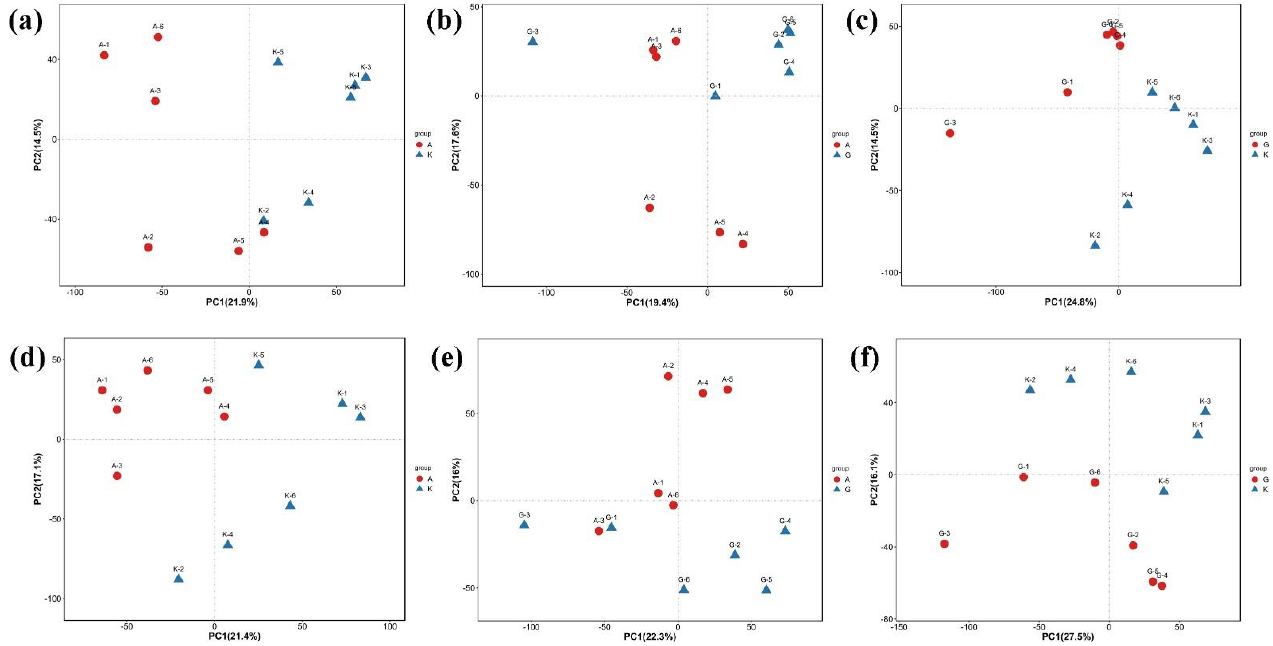
Figure 3. PCA analysis of samples. ( a ) PCA analysis of POS ions between Group A and Group K; ( b ) PCA analysis of POS ions between Group A and Group G; ( c ) PCA analysis of POS ions between Group G and Group K; ( d ) PCA analysis of NEG ions between Group A and Group K; ( e ) PCA analysis of NEG ions between Group A and Group G; ( f ) PCA analysis of NEG ions between Group G and Group K.